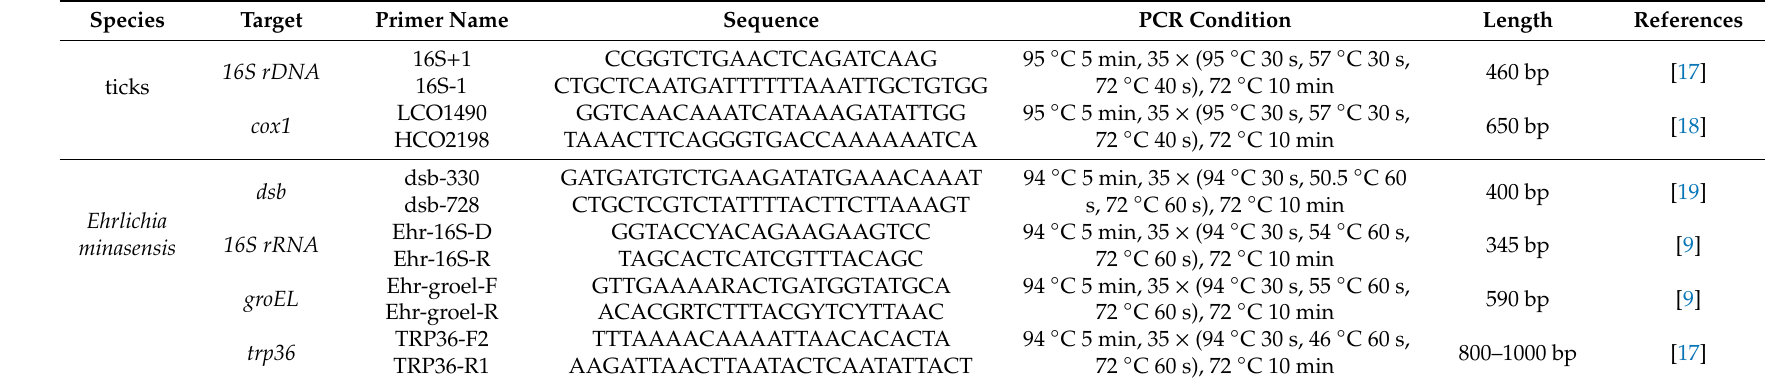
Table 1. Primers used in this